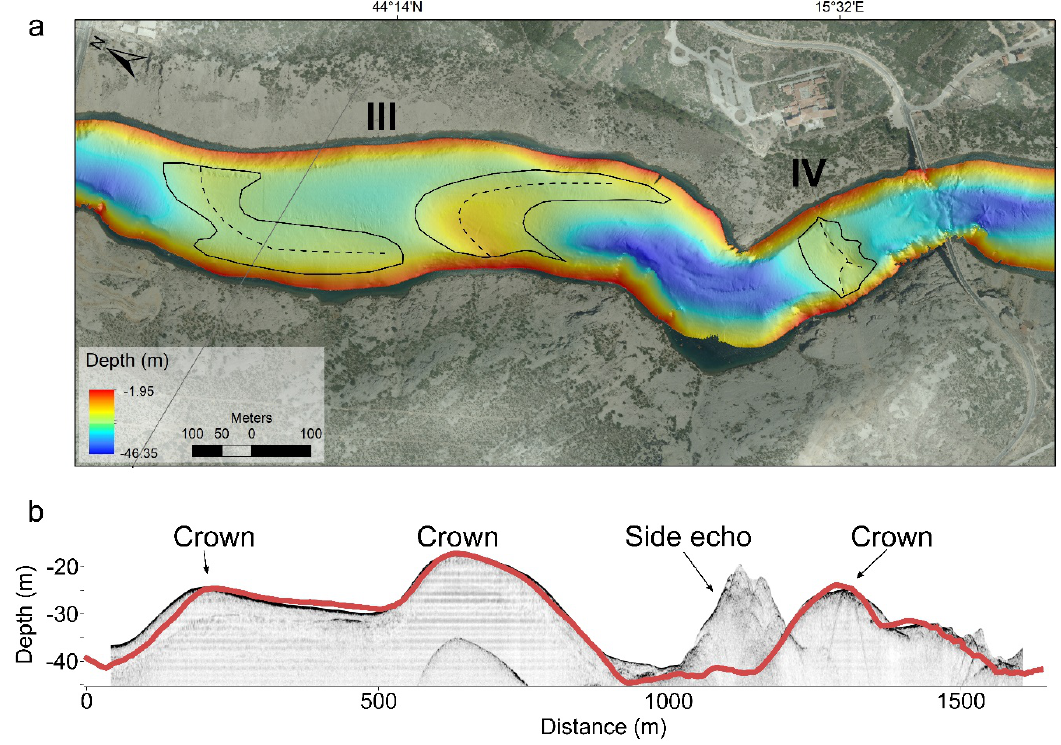
Figure 9. ( a ) Detailed MBES bathymetry map of barriers III and IV in NZD, with the outlined barriers and their crests (dashed line). ( b ) SBP profile of barriers III and IV that are overlain with the actual bathymetry profile over the central part of the canyon (red line).